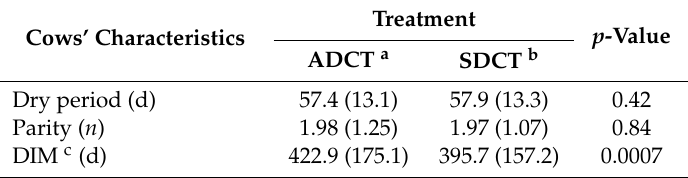
Table 1. Descriptive results of cows’ characteristics selected for the study (mean and standard deviation) and frequency of mammary quarter position according to the treatment groups